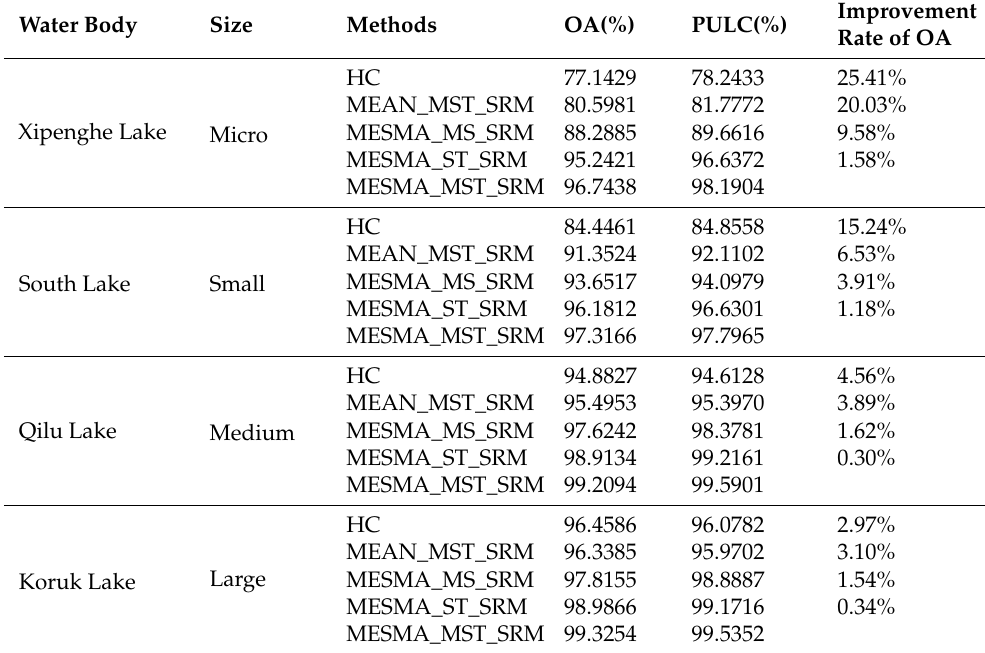
Table 3. Accuracy statistics comparison for different contained bodies of water such as lakes. Water